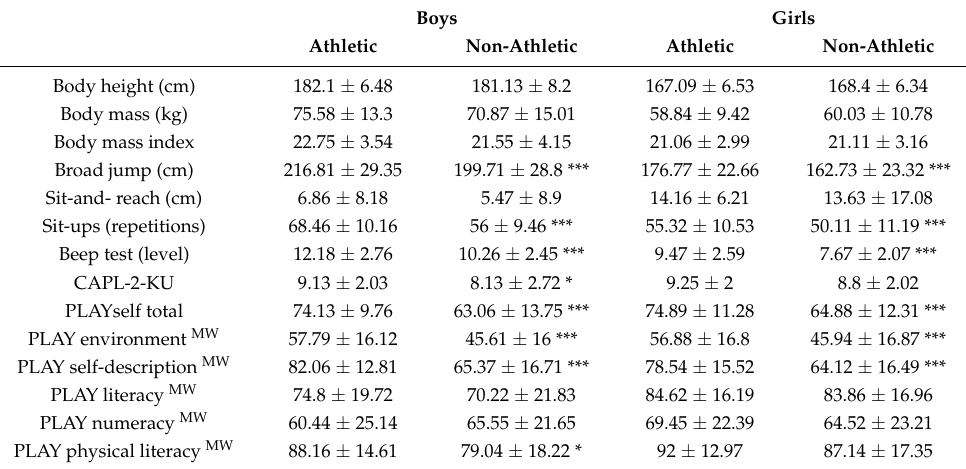
Table 1. Descriptive statistics and differences between groups based on sport participation (data are given as means ± SD).